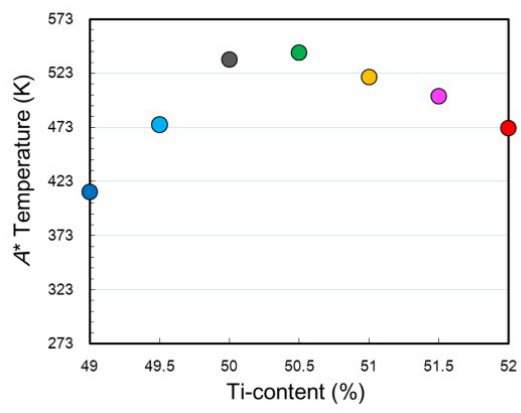
Figure 6. Ti-content dependence of the reverse transformation peak temperature ( A *).